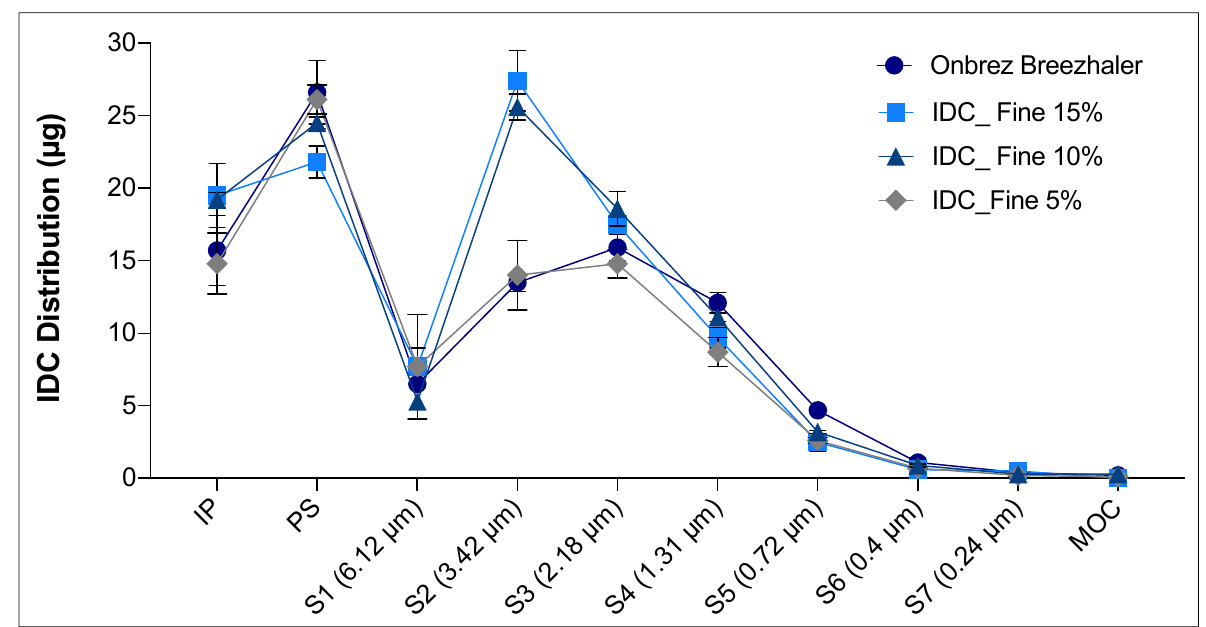
Figure 7. Indacaterol DPI (150 µ g/25 mg of blend) distribution in the NGI after a single dose aerosolisation. Three batches containing different amounts of fine lactose (IDC_Fine 5%, IDC_Fine 10%, IDC_Fine 15%) were compared with Onbrez ( n = 3, mean ± SD). Upper cut-off diameter of stages (S) is reported in the brackets, (IP = induction port, PS = pre-separator and MOC = micro orifice collec- tor).